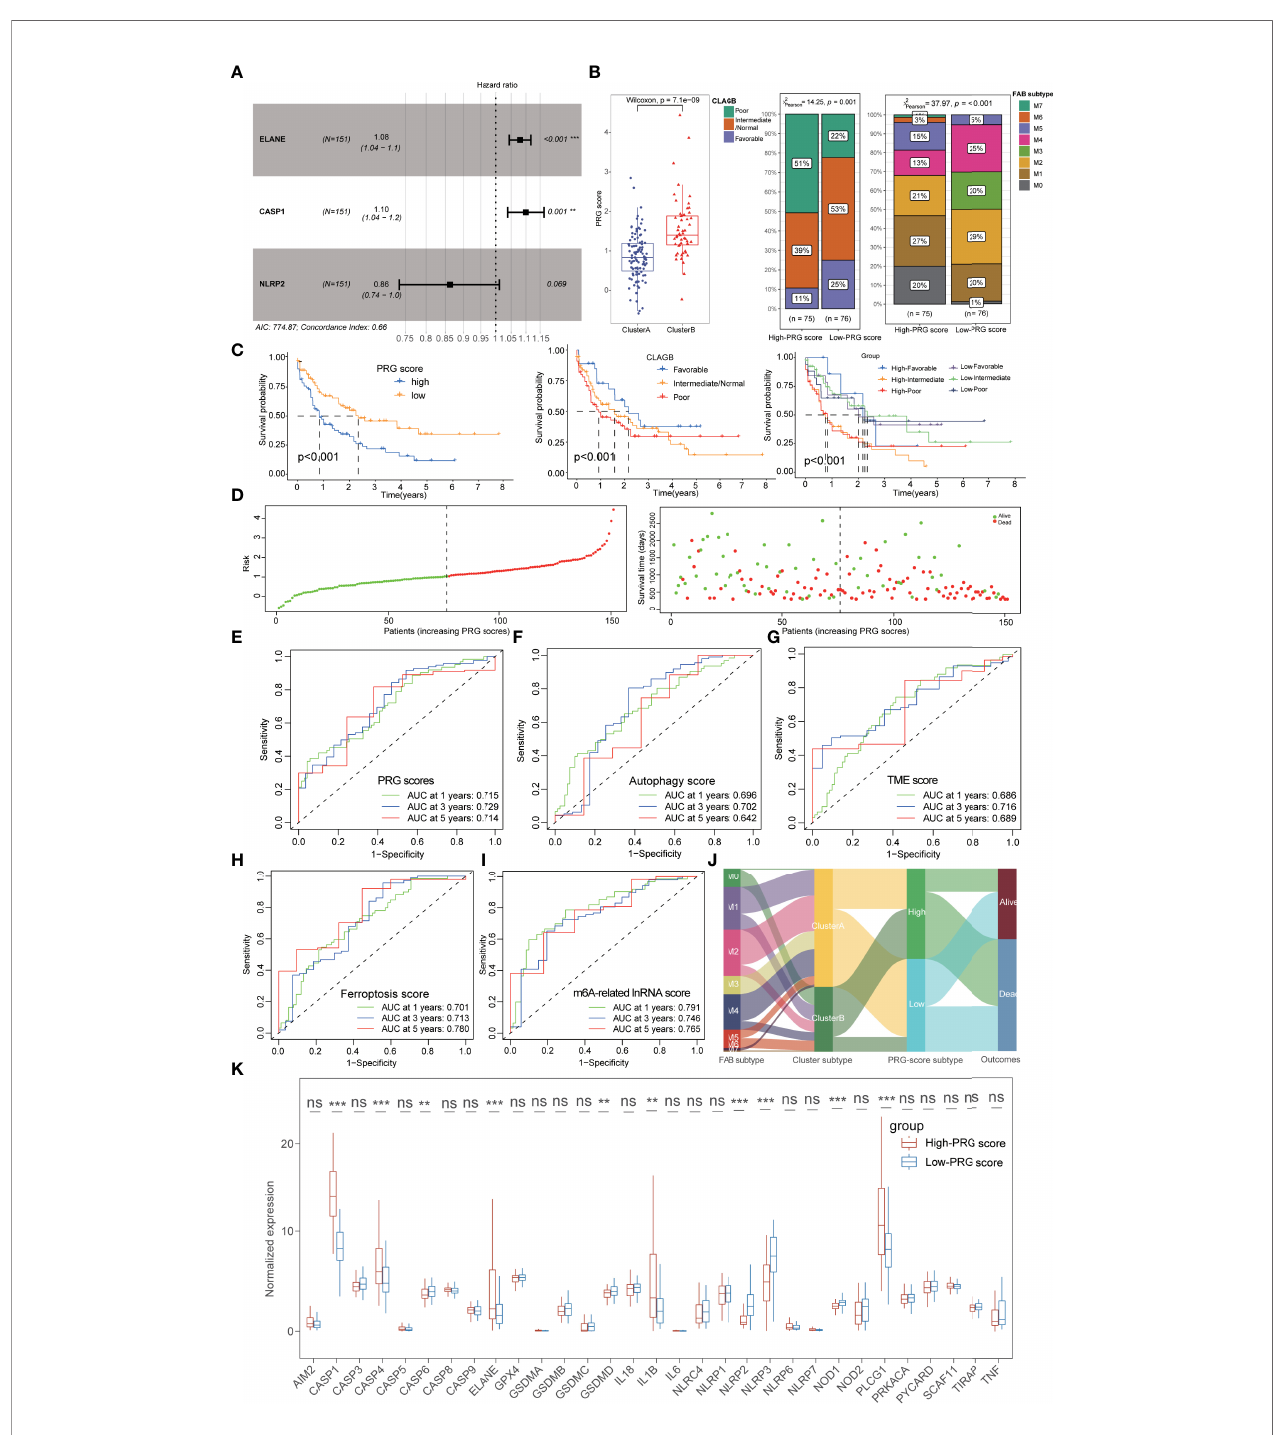
FIGURE 5 | Construction and prognostic characteristics of PRG scores. (A) Three PRGs (ELANE, CASP1, and NLRP2) were identi fi ed by multivariate Cox regression analysis. (B) Cluster A possessed lower PRG scores than those of cluster B patients, and the low-PRG score patients exhibited a longer survival time with better FAB subtypes and CLAGB outcomes. (C) The strati fi ed survival analysis based on PRG scores and CLAGB outcomes revealed that patients with low PRG scores had a better prognosis regardless of different outcomes. (D) The risk of death in AML patients also increased along with the increase of PRG scores. (E) ROC analysis revealed that the 1-,3-, and 5-year AUC values of the PRG score were 0.715, 0.729, and 0.714. (F – I) ROC analysis compared the 1-, 3-, and 5-year AUC values of multiple previous signatures for AML, with 0.696/0.702/0.642 in autophagy score (F) , 0.686/0.716/0.689 in TME score (G) , 0.701/0.713/0.780 in ferroptosis score (H) , and 0.791/0.746/0.765 in m6A-related lncRNA score (I) . (J) The alluvial diagram visualized the status changes in patients ’ different subtypes. (K) The boxplots showing the signi fi cant expressional differences of PRGs between high- and low-PRG score groups. *P<0.05, **P<0.01, ***P<0.001; ns, not signi fi cant.